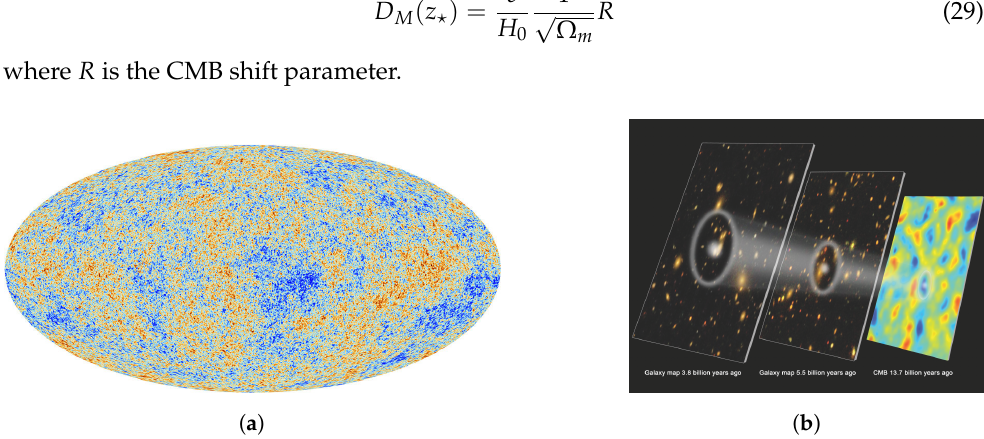
Figure 9. ( a ) The cosmic microwave background (CMB) as seen by the Planck satellite. Adapted from: [30]. ( b ) BAO evolution since the CMB. Adapted from: [26]. Shift Parameter